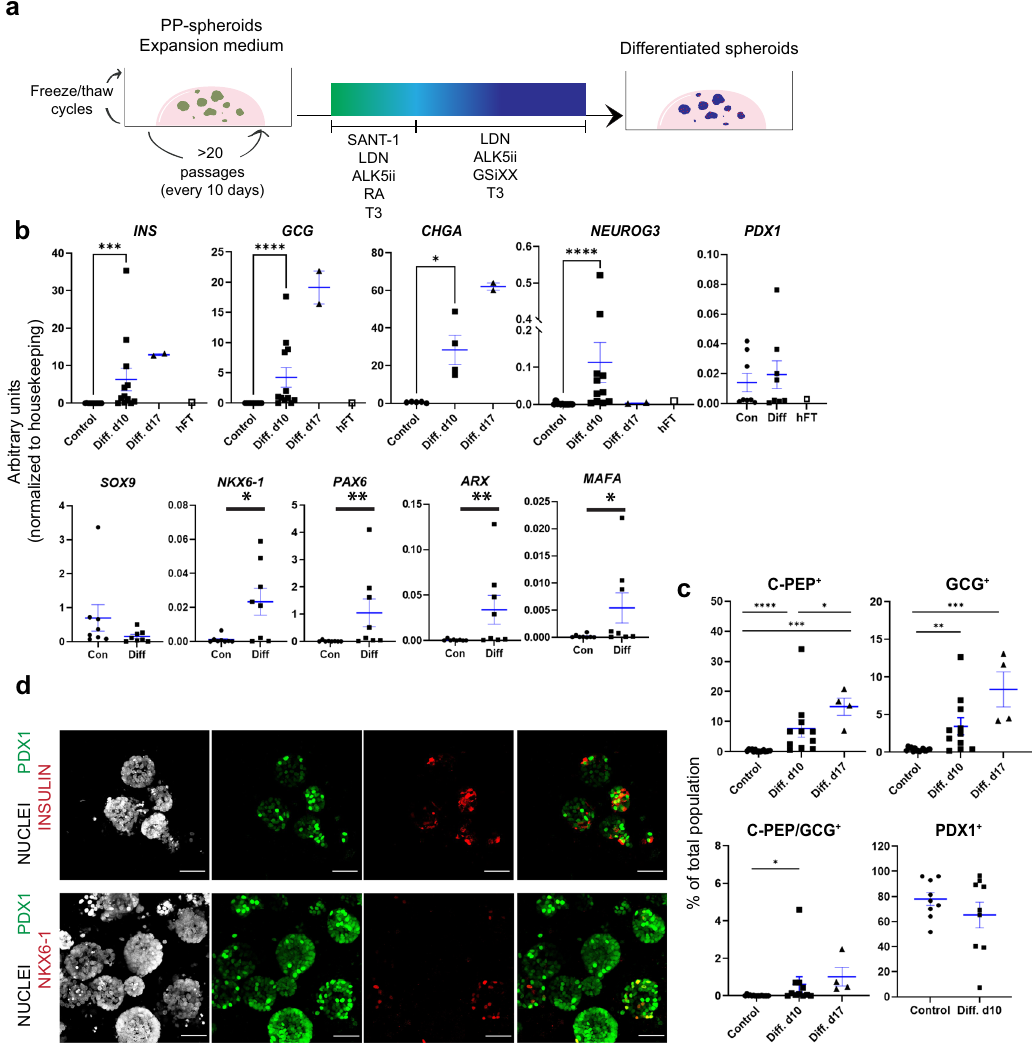
Fig. 5 Endocrine differentiation can be triggered in expanded PP-spheroids. a Day 10 PP-spheroids (from HuES4, H9, H1, and SBAD3.4) in expansion medium for at least 2 passages after thawing were changed to a differentiation medium with two distinct stages (based on stages 5 (3 days) and 6 (7 or 14 days) of the Rezania et al. 16 protocol) and analyzed after 10 days or 17 days. b Summary of qPCR analyses. Expression levels normalized to housekeeping genes are shown for PP-spheroids in expansion conditions (con) and after differentiation (diff). A fetal pancreas sample (9 + 3 wpc) was included as a control for some targets, N = 6 – 11, N = 2 for day 17. Data shown as mean ± SEM. * P < 0.05, ** P < 0.01, *** P < 0.001, **** P < 0.0001. P values